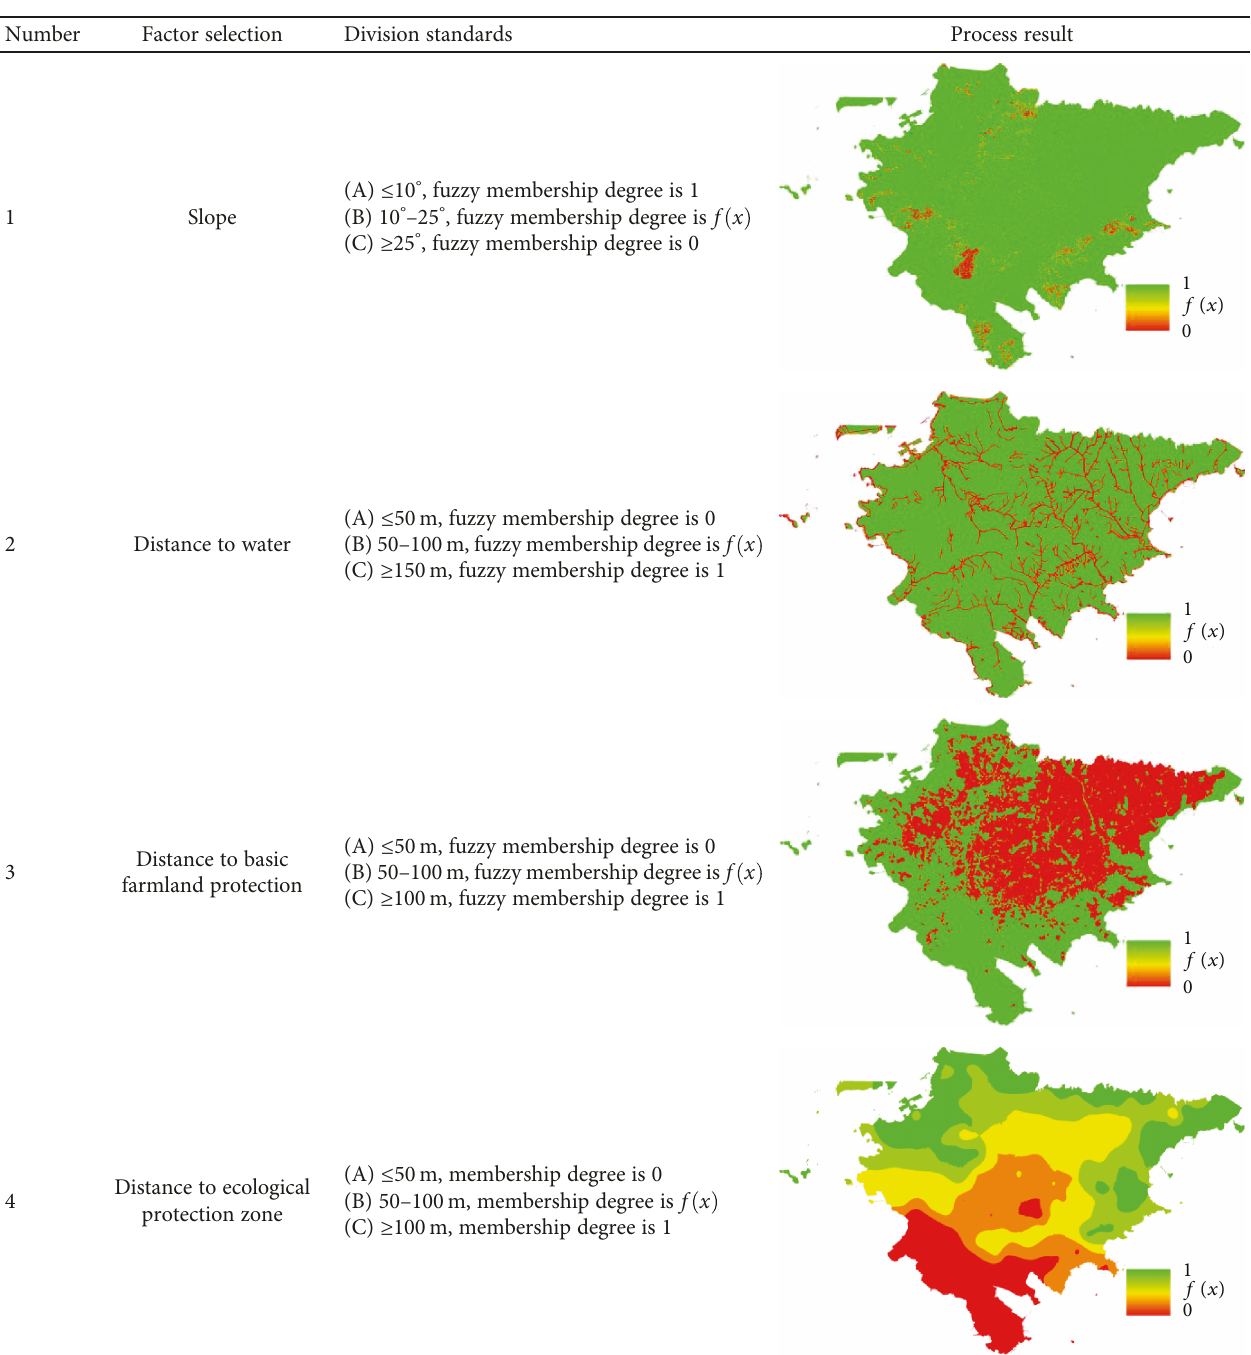
Table 6: Selection and processing of ecological suitability